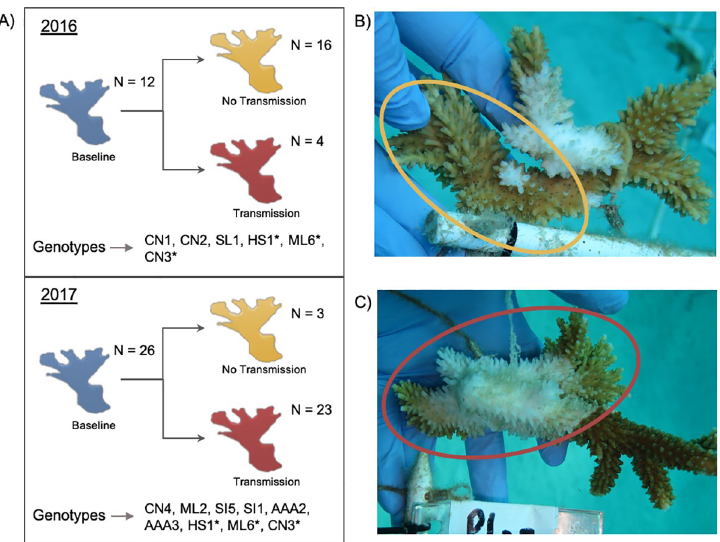
Fig 1. Experimental summary for transcriptomic analysis. A) A general overview of the field experiment conducted in 2016 and 2017. Samples were taken before disease grafting (blue = Baseline) and after 7-days of disease grafting, with samples classified as showing no signs of disease transmission (yellow = No Transmission) or signs of disease transmission (red = Transmission). Genotypes sequenced are listed below. Genets with a � were tested in 2016 and 2017. B) The yellow circle indicates the apparently visually healthy A . palmata fragment grafted to the diseased A . cervicornis fragment after exposure for 7-days resulting in it being classed as No Transmission. C) The red circle indicates A . palmata fragment showing disease signs grafted to the diseased A . cervicornis fragment after 7 days resulting in it being classed as Transmission.